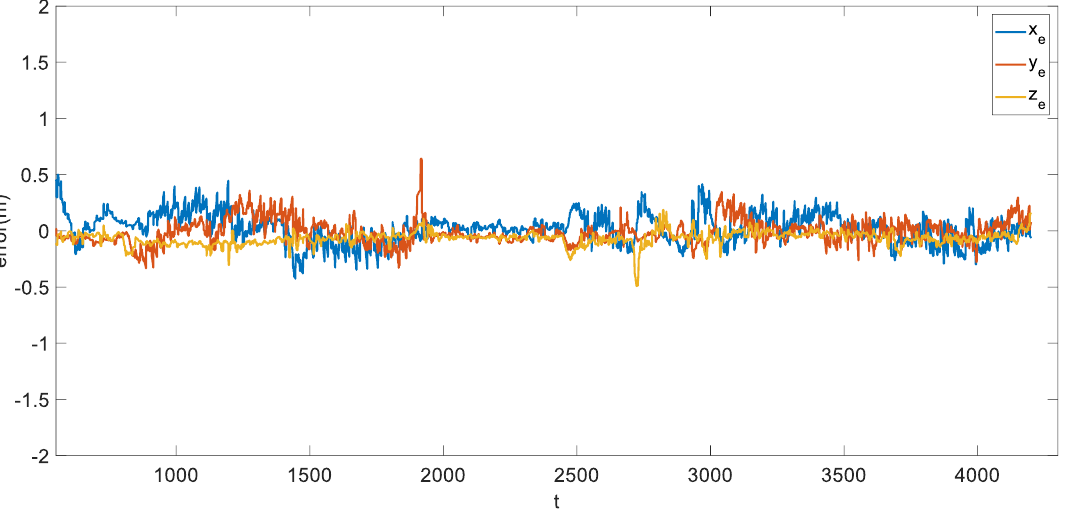
Figure 11. Error throughout the mission time.